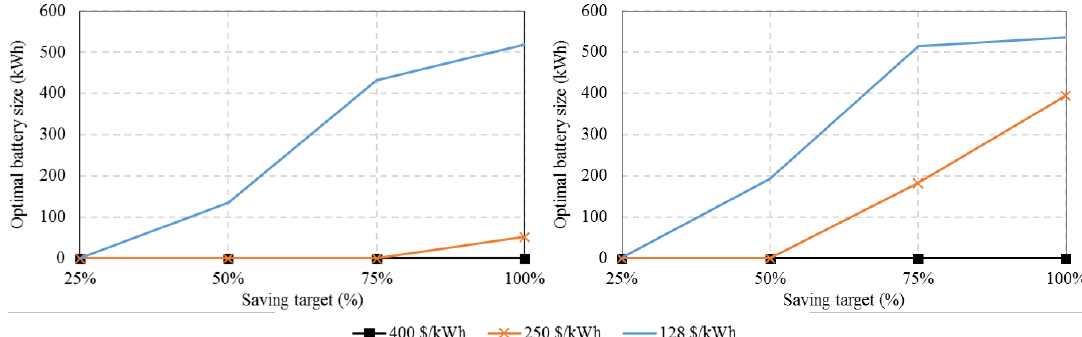
Figure 14. The optimum capacity of the battery along with the saving targets for feed-in tariff =6.7 ₵ /kWh ( left ), and 3.35 ₵ /kWh ( right ).